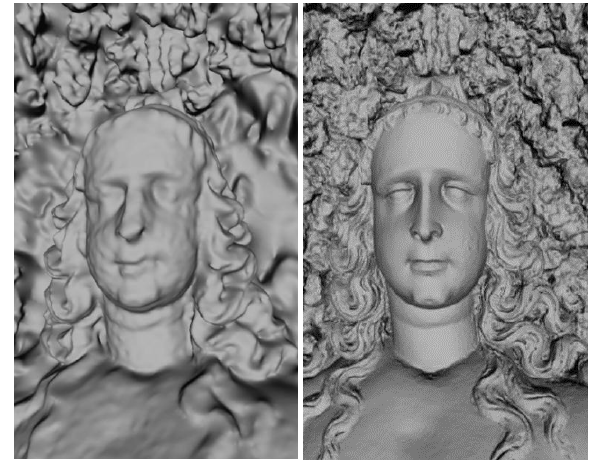
Figure 19. Statue model in Sala Terrena created from TLS data and model after addition of DP